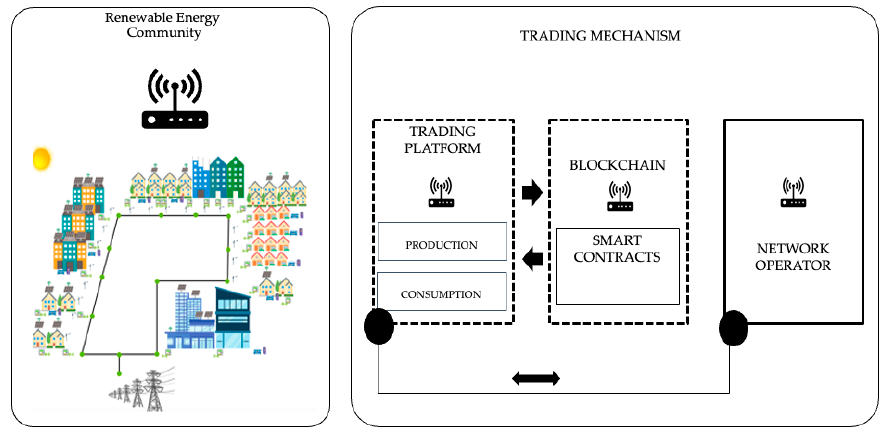
Figure 9. Peer-to-peer (P2P) trading platform concept.